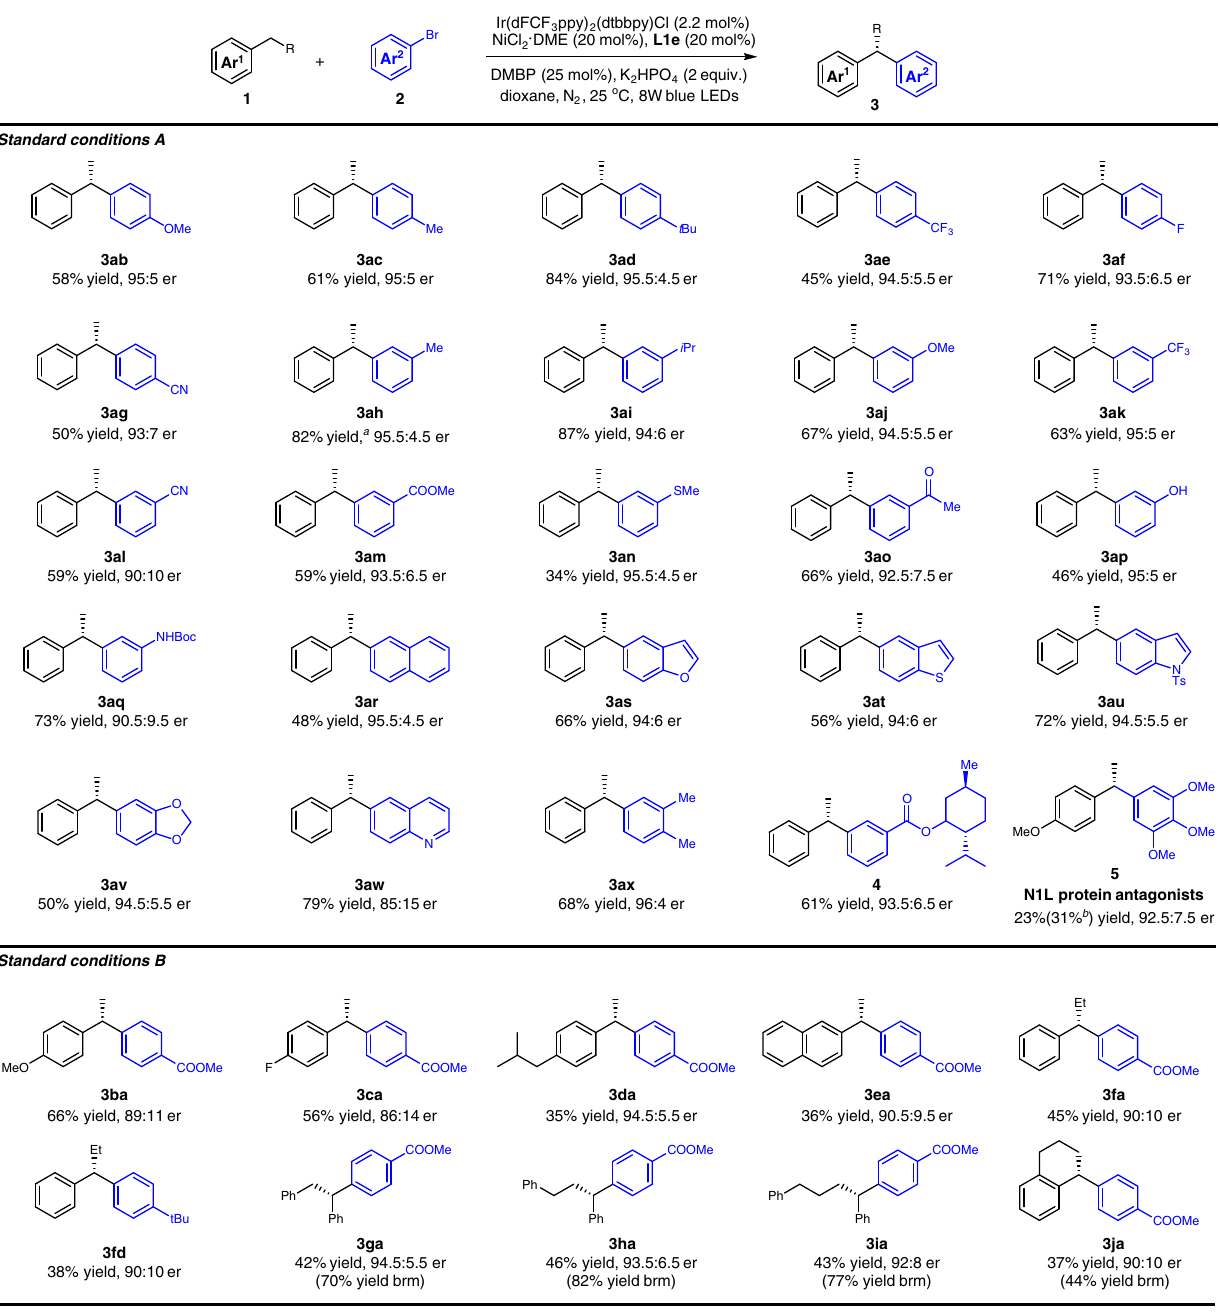
Fig. 2 Substrate scope. Standard conditions A: 1 (1.0 mL), 2 (0.2 mmol), Ir(dFCF 3 ppy) 2 (dtbbpy)Cl (2.2 mol%), NiCl 2 ·DME (20 mol%), L1e (20 mol%), DMBP (25 mol%), and K 2 HPO 4 (2.0 eq.) in dioxane (3 mL) under the irradiation of 8 W blue LEDs for 34 h. Standard conditions B: 1 (0.8 mmol), 2 (0.2 mmol), Ir(dFCF 3 ppy) 2 (dtbbpy)Cl (2.2 mol%), NiCl 2 ·DME (20 mol%), L1e (20 mol%), DMBP (25 mol%), and K 2 HPO 4 (2.0 eq.) in dioxane (3 mL) under the irradiation of 8 W blue LEDs for 96 h. Isolated yield, the er was determined by HPLC. a For 48 h. b NMR yield using TMSPh as an internal